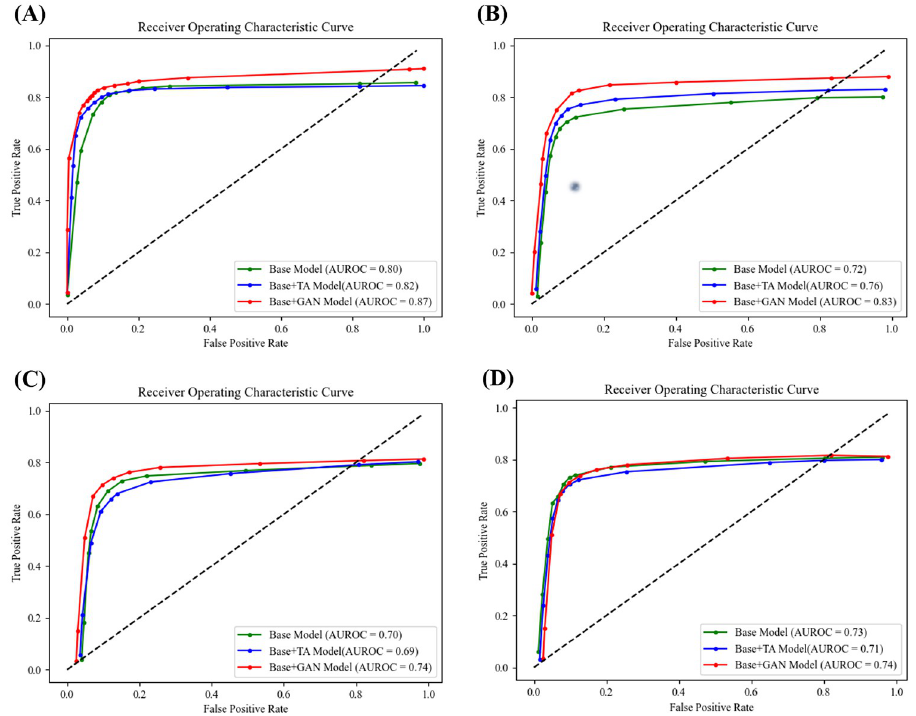
Fig 4. ROC curves of classifiers. (A) ResNet50, (B) VGG16, (C) InceptionV3, and (D) DenseNet121.